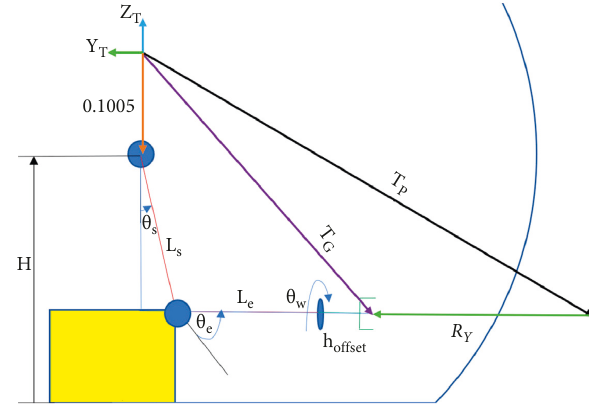
Figure 9: Grabbing horizontally.